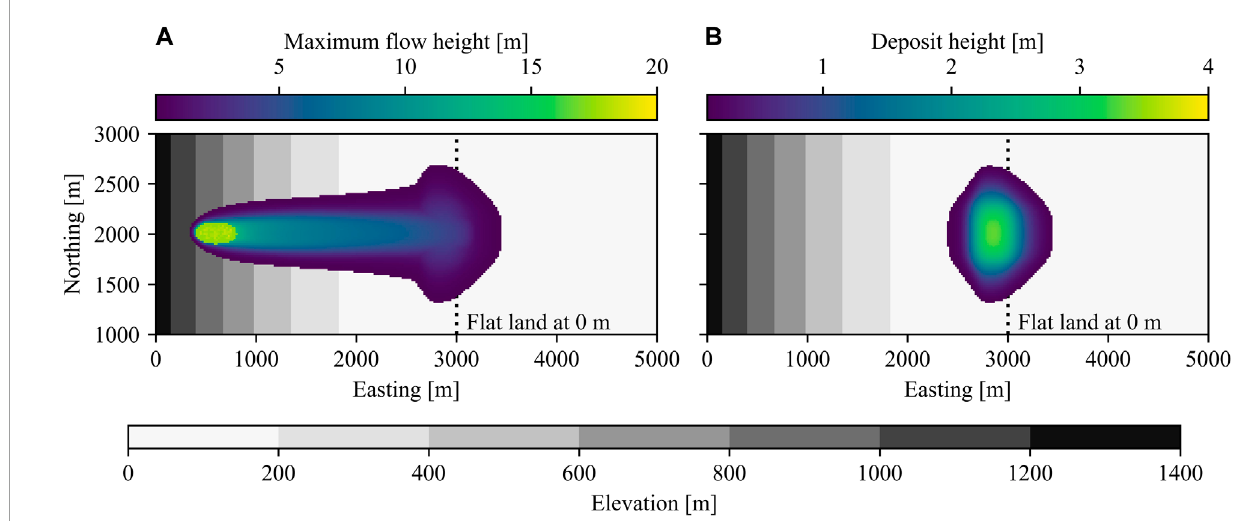
FIGURE 1 (A) Maximum flow height and (B) deposit height from a simulation of the synthetic case.